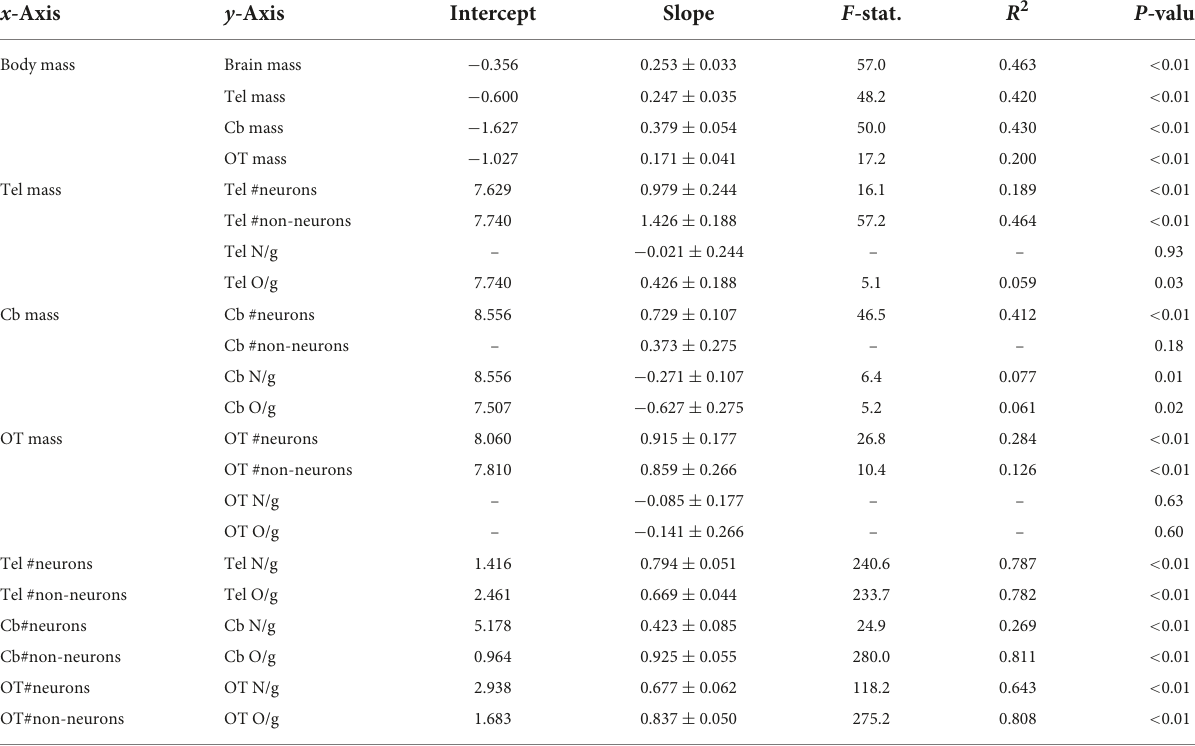
TABLE 2 Details of the allometric relationships among the measurements examined and including all individuals.